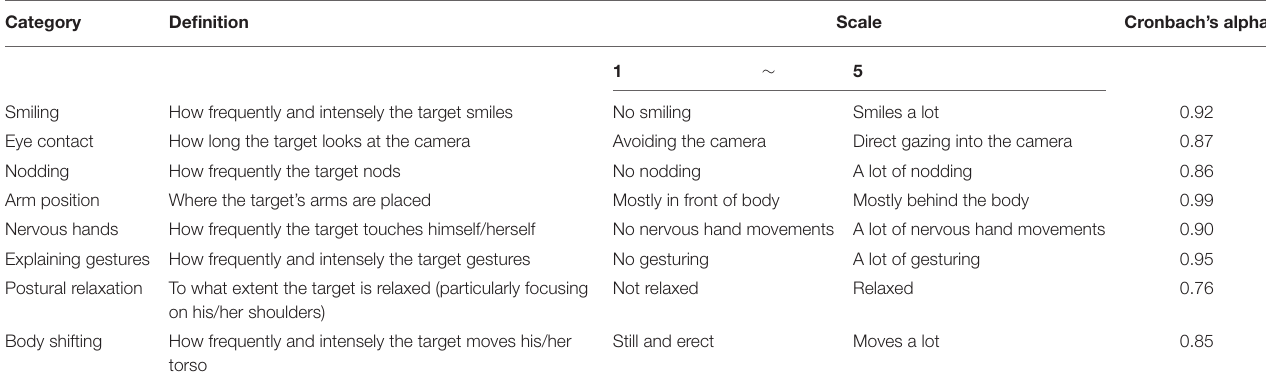
TABLE 1 | Nonverbal behavior categories and inter-rater reliability. Category